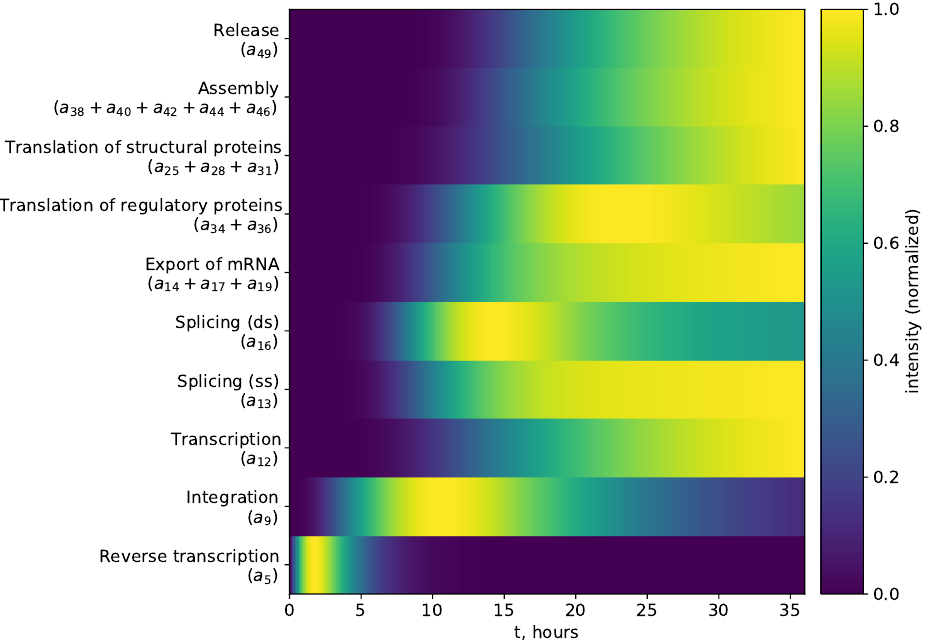
Figure 6. Temporal dynamics of the intensities of stages of the HIV-1 replication life cycle. The propen- sities that constitute each stage intensity are indicated on the vertical axis. The propensities represent the average values over stochastic realizations normalized by their maximum